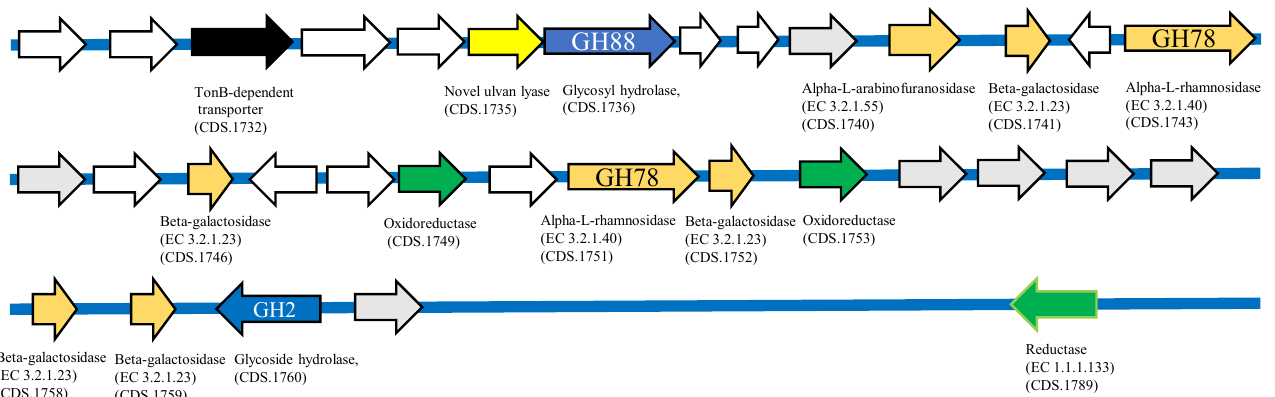
Figure 7. PUL 2 of a putative ulvan-degrading-related gene of Echinicola sp. 20G. White arrows indicate hypothetical protein and gray arrows indicate genes that are not relevant to ulvan degradation.